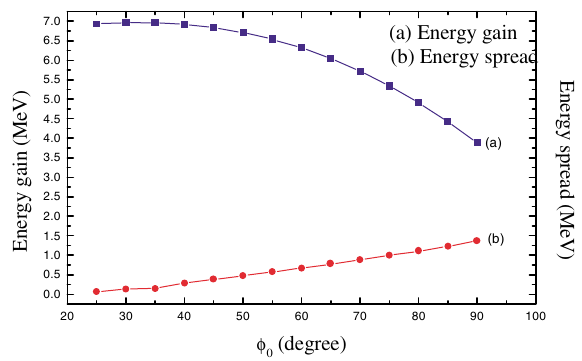
FIG. 7. (Color) Energy gain and energy spread in the photo- cathode gun as a function of the beam injection phase.